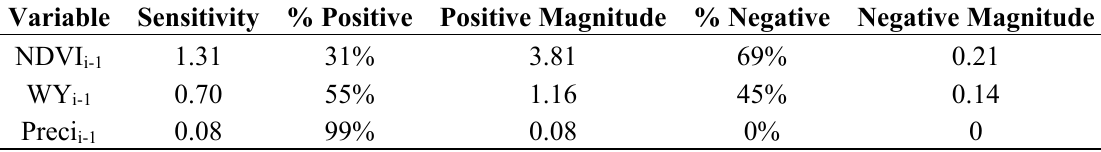
Figure 3. Mathematical solution accuracy vs. model complexity in the SR method. Y-axis shows mean absolute error of the forecast vs. observations for the entire data. Table 1. Sensitivity analysis of the optimum solution derived from SR.